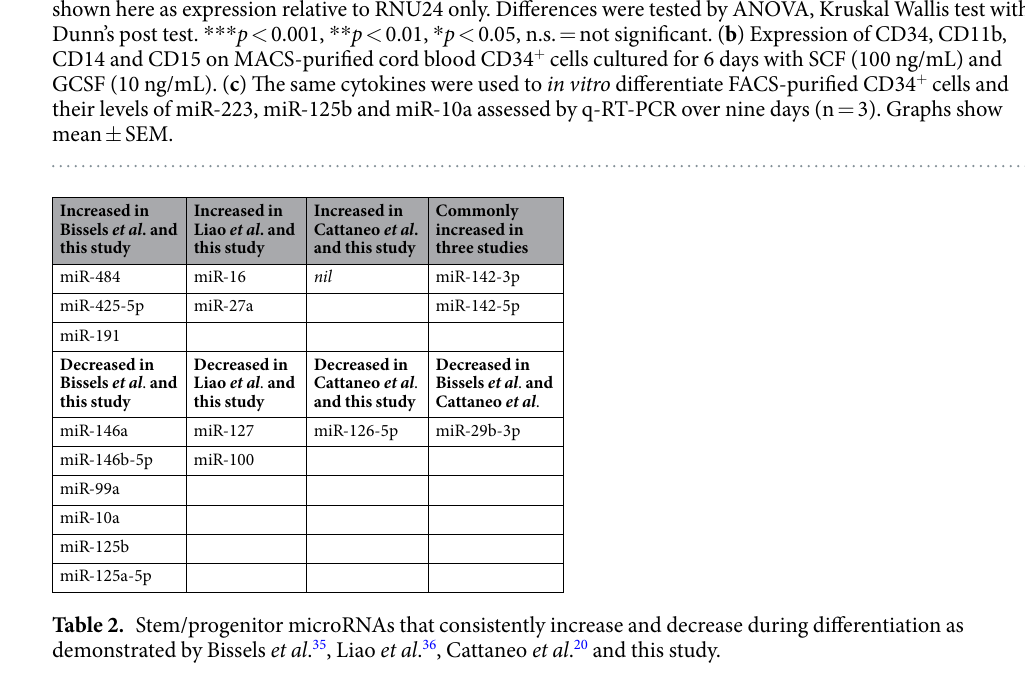
uses sequence composition, conservation and thermodynamic stability as criteria for predicting miRNA tar- get sites. This algorithm applies a sensitive method that has a high relative overlap with predictions from other algorithms. The top 1000 gene candidates that were increased in monocytes and granulocytes versus myeloid progenitors were combined with the target predictions for miR-125b and miR-10a (Fig. 4c and d). The resulting 162 candidates for miR-125b and 161 candidates for miR-10a that were both predicted targets and had inverse expression patterns to the miRNAs were investigated further through literature searches. This process resulted in the selection of three putative targets for confirmatory testing using the luciferase reporter assay ( MCL1 , FUT4